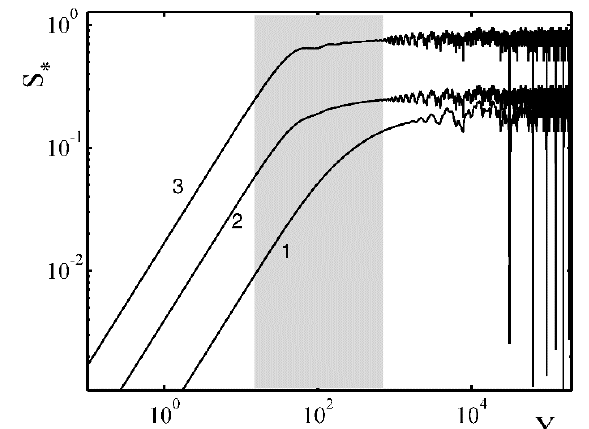
Figure 13: Power spectrum of the intensity fluctuations as log-log plots of the frequency parameter . Irregularities are moving along the X -axis.